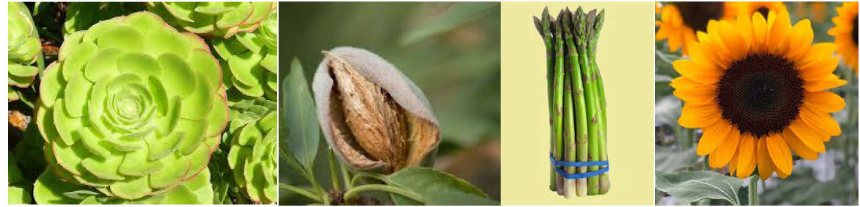
Figure 7. Example images of Plants dataset used in our experiment. Left to right: images of aeonium, almond, asparagus, and